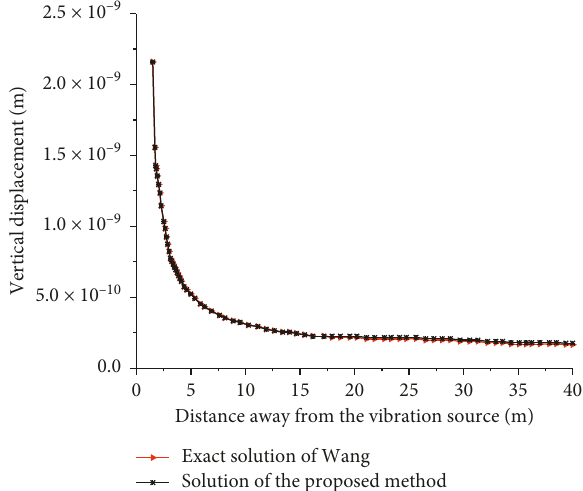
Figure 2: Comparison of the performance of the methods used for vertical displacement.